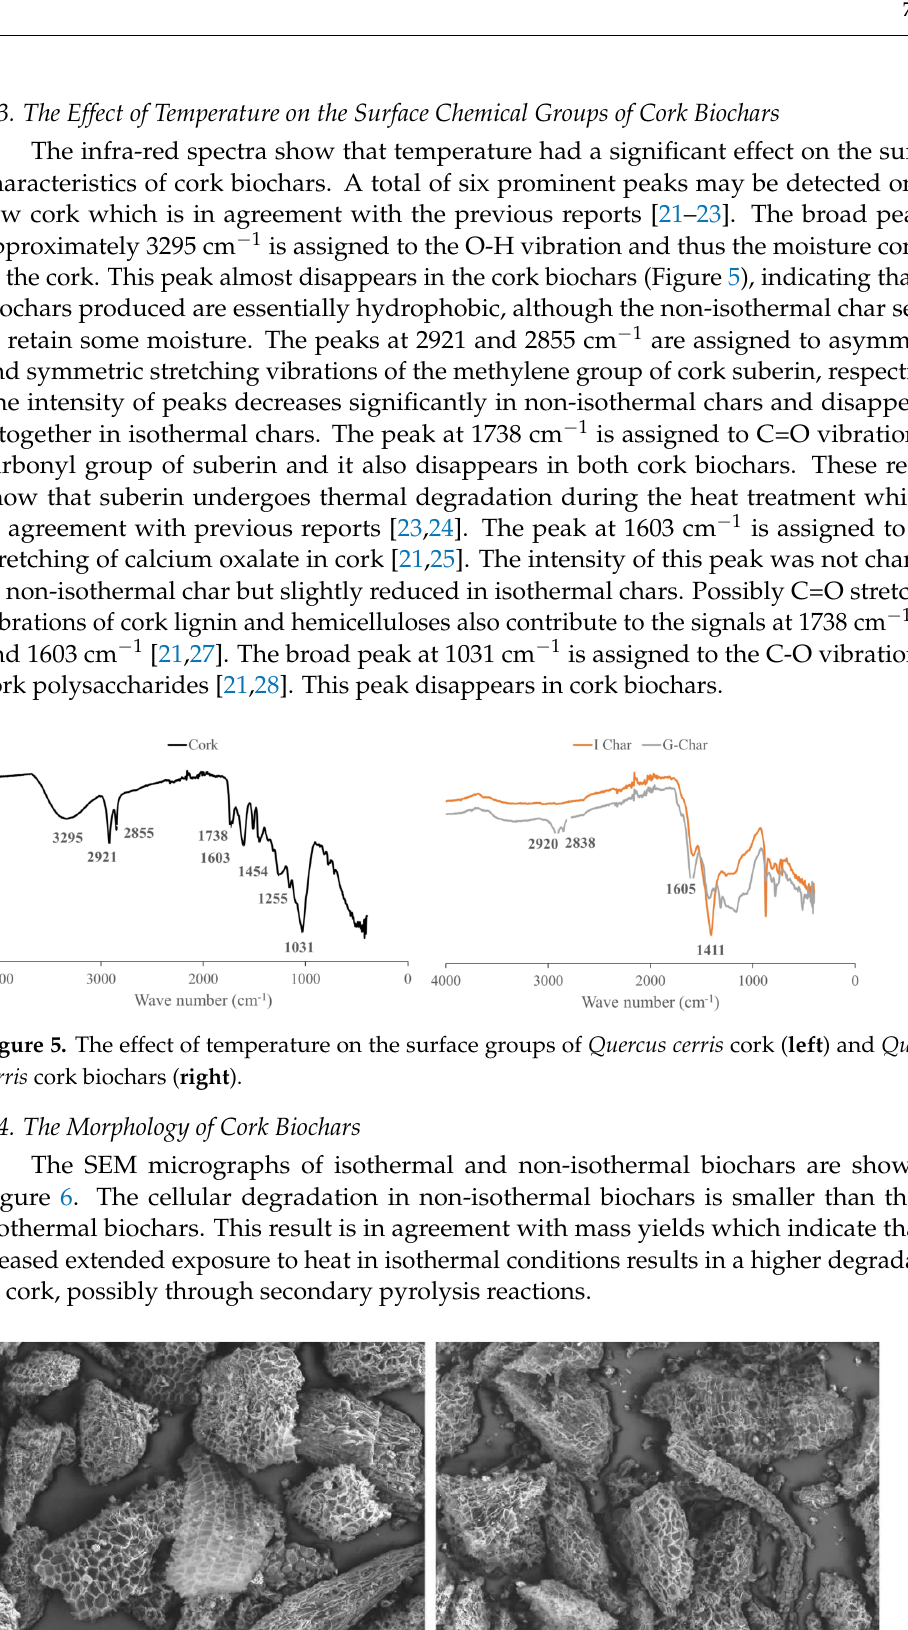
Figure 4. Temperature profile for the non-isothermal reactor containing the cork sample, corre- sponding temperature in the oven, and temperature difference between the reactor containing the sample and the empty reactor for the same temperature program.